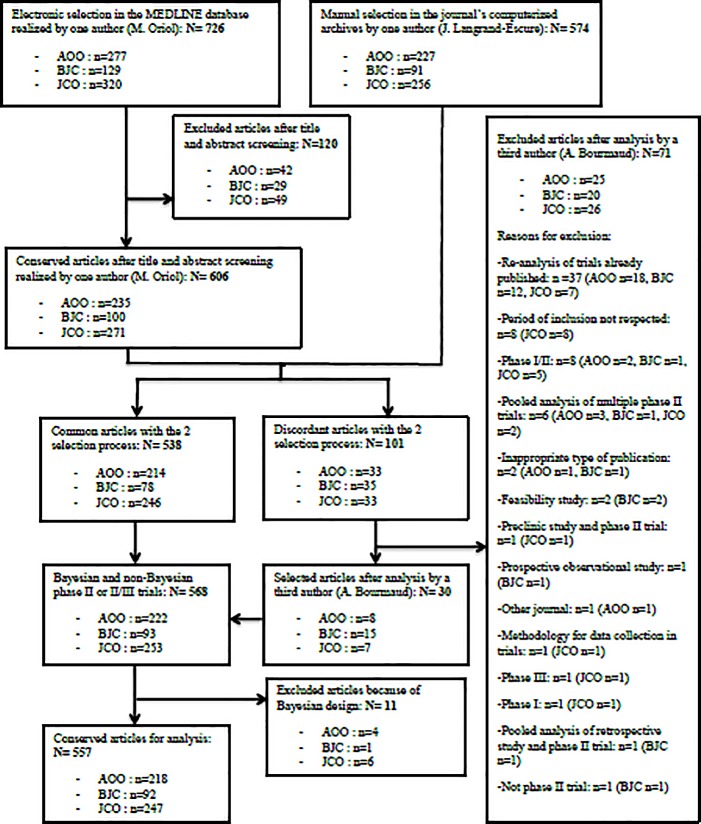
Flowchart.—Flowchart summarizing the selection process of the phase II trials for analysis (AOO: Annals of Oncology; BJC: British Journal of Cancer; JCO: Journal of Clinical Oncology).